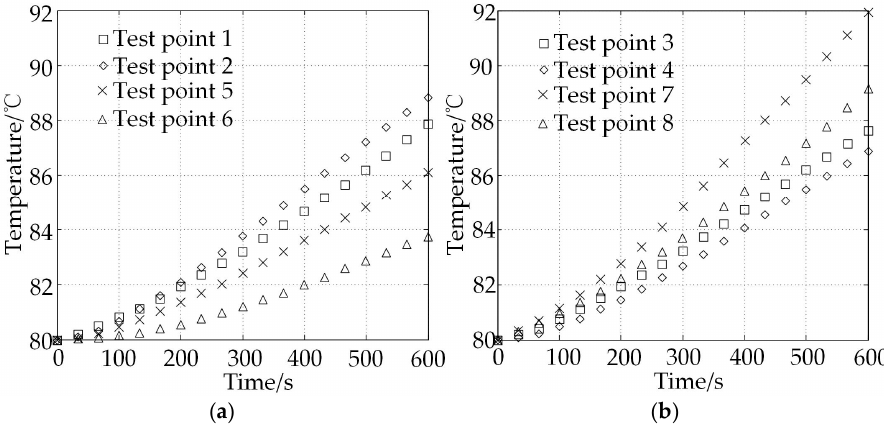
Figure 11. The test point temperatures of 80 °C-300 rpm-6 Nm mode. ( a ) Temperature of point 1, point 2, point 5, and point 6; ( b ) Temperature of point 3, point 4, point 7 and point 8.